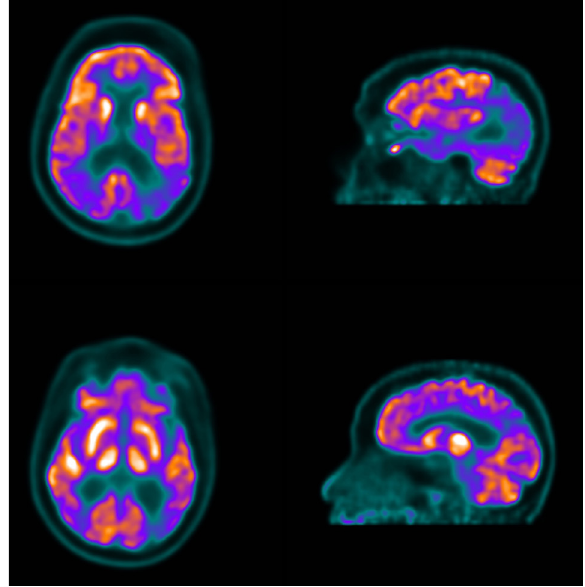
Figure 5. Example of PET findings in Lewy Body Dementia. Note marked hypometabolism in parietal and occipital regions of the brain, a distinct pattern from